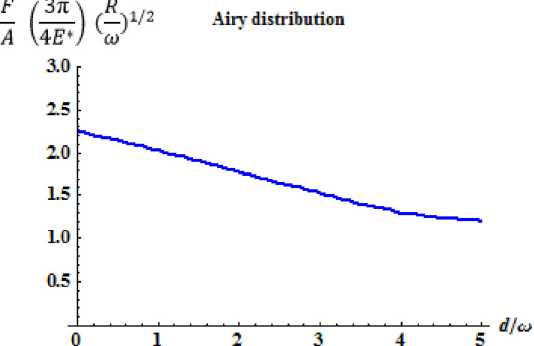
Fig. 5 Airy distribution has used as summits’ distribution with Hertzian contact. In comparison with other EVS distributions and even Gaussian distribution, it has the biggest variation in pressure.